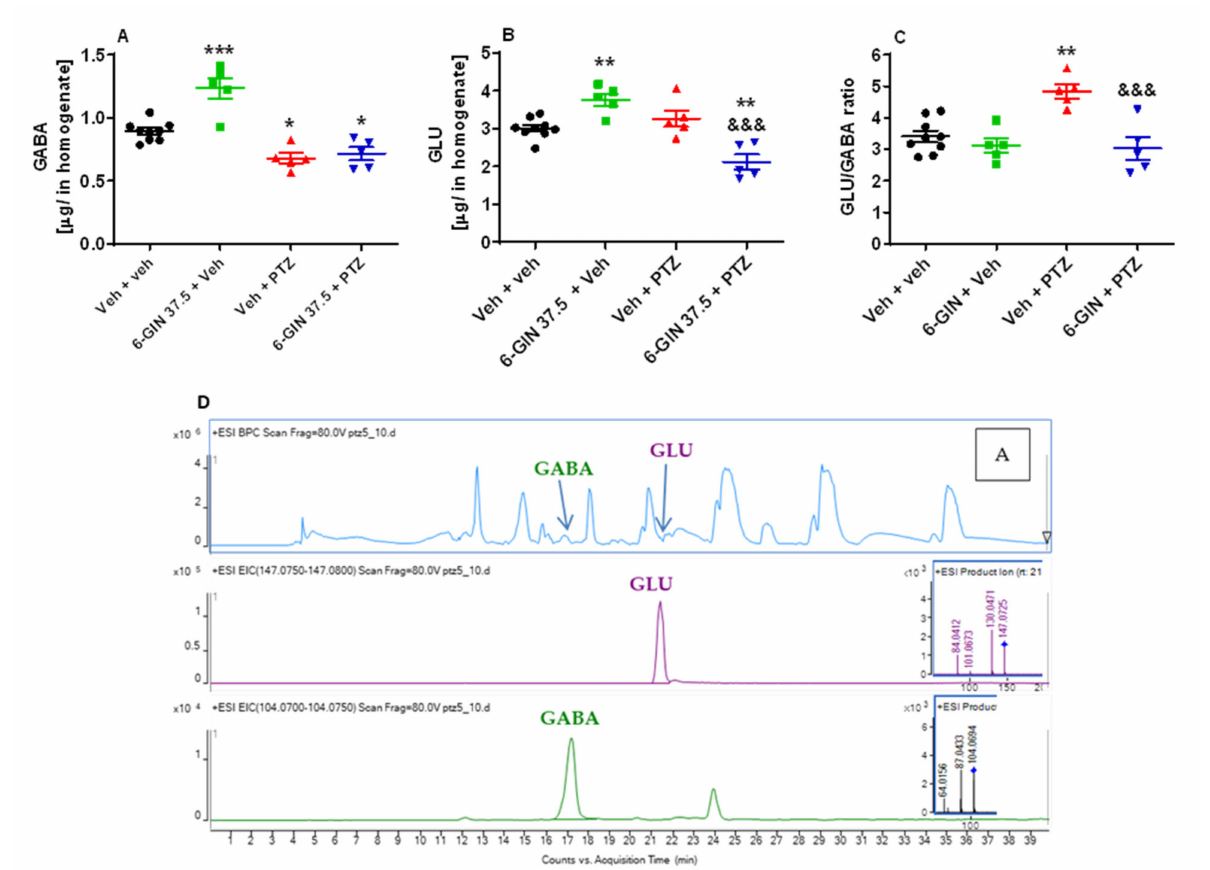
Figure 6. Determination of ( A ) GABA, ( B ) GLU, ( C ) GLU/GABA ratio, and ( D ) the total ion chromatogram ( A ) of the water: acetonitrile extract from zebrafish larvae with extracted ion chromatograms and MS/MS spectra of GLU and GABA in 7-day-old zebrafish larvae by HPLC-MS. After a 24 h incubation in 6-GIN (37.5 µ M), zebrafish larvae were exposed to an acute dose of PTZ (20 mM) for 90 min. Next, whole zebrafish larvae were collected in a pool of n = 100/sample. Data were analyzed using one-way ANOVA followed by Tukey’s post hoc test. Data are depicted as mean ± SEM. Veh + veh ( n = 9), 6-GIN 37.5 + Veh ( n = 5), Veh + PTZ ( n = 5), 6-GIN 37.5 + PTZ ( n = 5). *** p < 0.001, ** p < 0.01, * p < 0.05 vs. Veh + veh; &&& p < 0.001 vs. Veh + PTZ. 6-GIN—6-gingerol, PTZ—pentylenetetrazole, Veh—vehicle. n —refers to the total number of